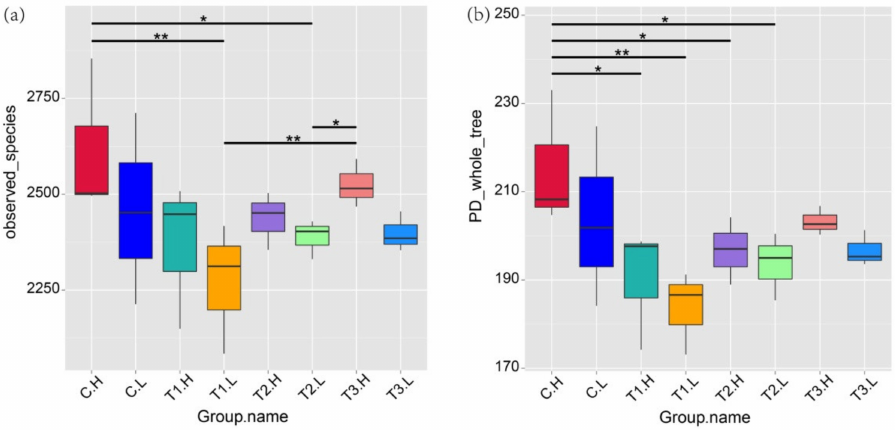
Figure 4. Microbial alpha diversity indexes of sediment samples. Observed_species ( a ) and PD_whole_tree ( b ). The samples numbers are shown in Figure 2. A single asterisk indicates p < 0.05, a double asterisk indicates p < 0.01. The line under the asterisk indicates that the samples below it are significantly di ff erent.